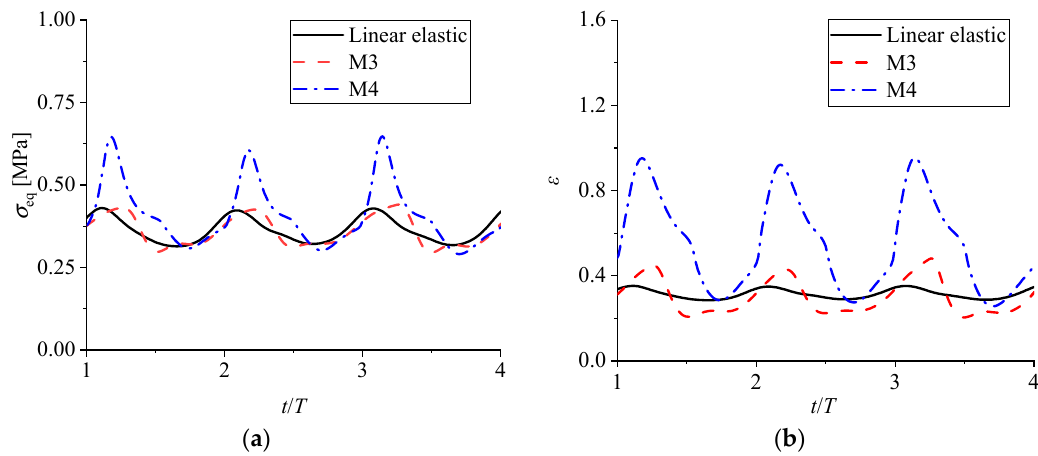
Figure 18. Time history of the variation of ( a ) stress σ eq and ( b ) strain τ of the tip for different materials.